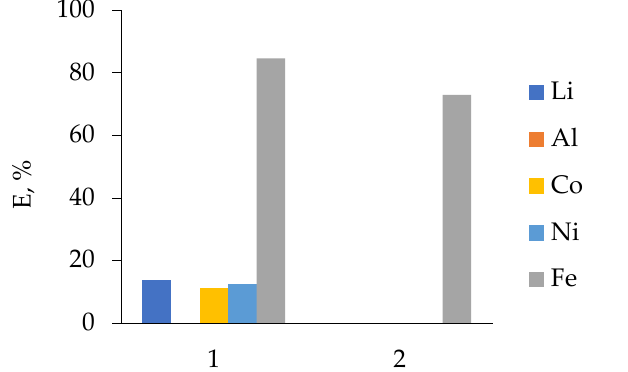
Figure 7. Extraction of metal ions with HDES 1 from the LIB 2 leaching solution at O/A phase ratios of: 1—1/5; 2—1/1. Extraction of Co(II) . Further, the extraction of Co(II) with HDES 1 from the leaching solution was studied as a function of hydrochloric acid concentration in the range from 3